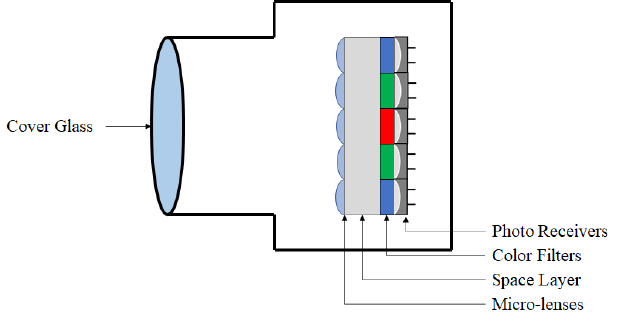
Figure 2. Camera components.